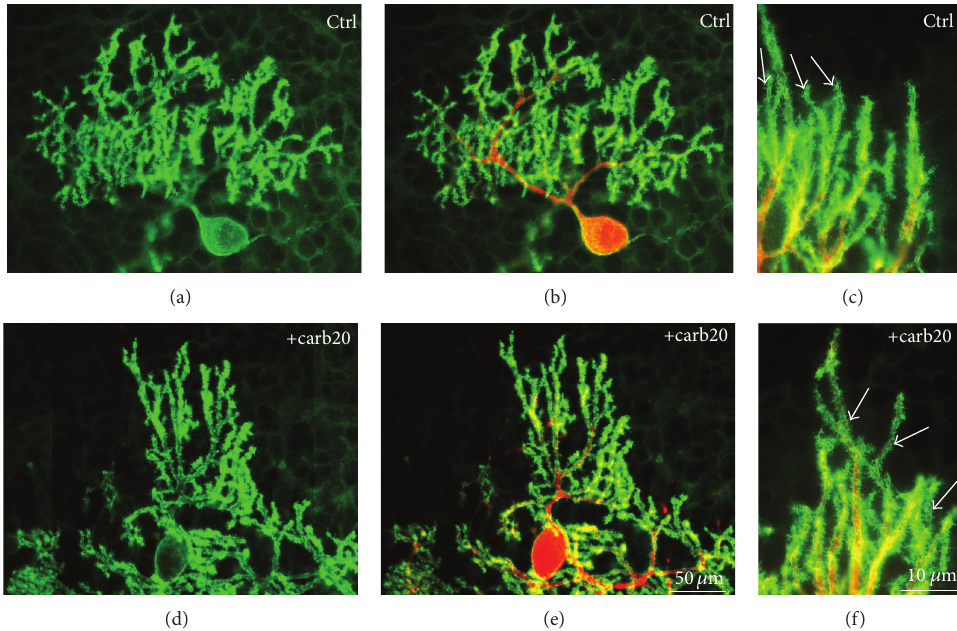
Figure 1: Staining of anti-calcium pump PMCA2 ATPase and calbindin D-28K in Purkinje cells in organotypic slice cultures: (a–c) untreated control cultures, (d–f) carboxyeosin-treated cultures. (a) Untreated control showing abundant expression of PMCA2 in dendrites and dendritic spines (green). (b) Merged red Purkinje cell soma with higher expression of PMCA2 in dendrites. (c) Abundant expression of PMCA2indendriticplasmamembraneanddendriticspines. (d)Carboxyeosin-treatedPurkinjecellshowingabundantexpressionofPMCA2 in dendrites and dendritic spines (green). (e) Red Purkinje cell soma with higher expression of PMCA2 in dendrites and dendritic spines. (f) Abundant expression of PMCA2 in dendritic plasma membrane and dendritic spines. Scale bar 50 𝜇 m (a-b, d-e) and 10 𝜇 m